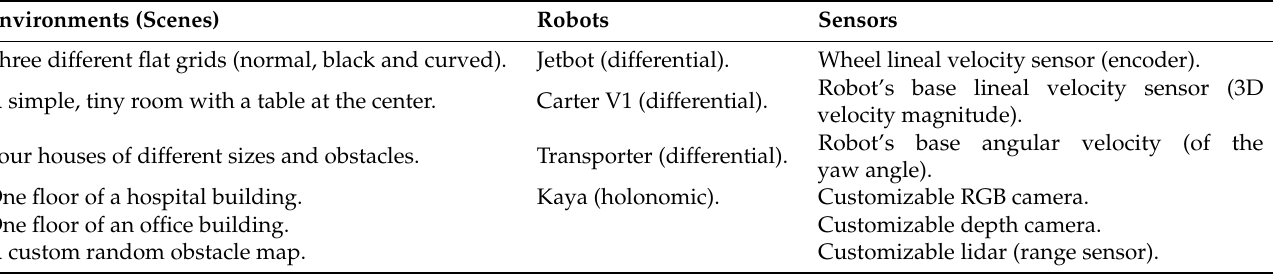
Table 2. Library’s available